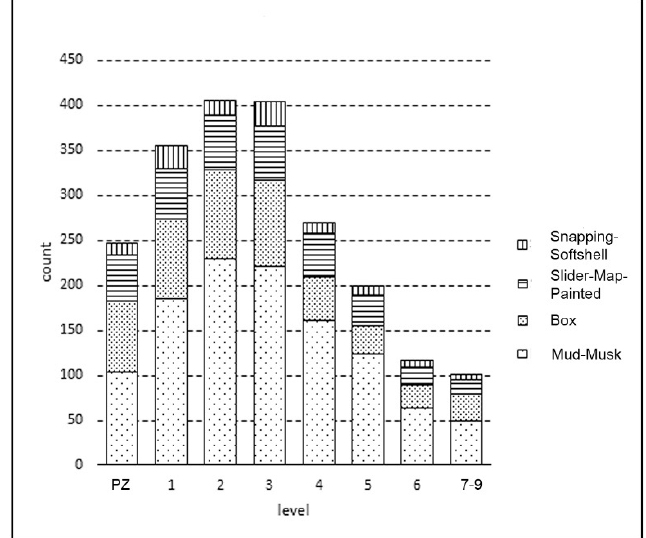
Figure 4. Turtle taxon counts by level.